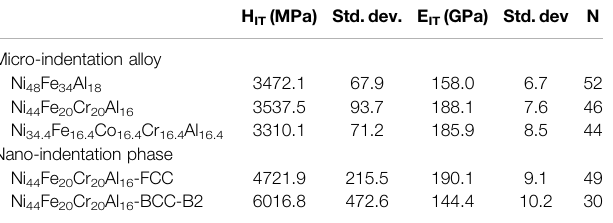
TABLE 4 | Instrumented hardness (H IT ) and Young ’ s modulus (E IT ) for the three alloys as determined by micro-indentation experiments and for the individual phases of the Ni44Fe20Cr20Al16 alloy as determined by nano-indentation.